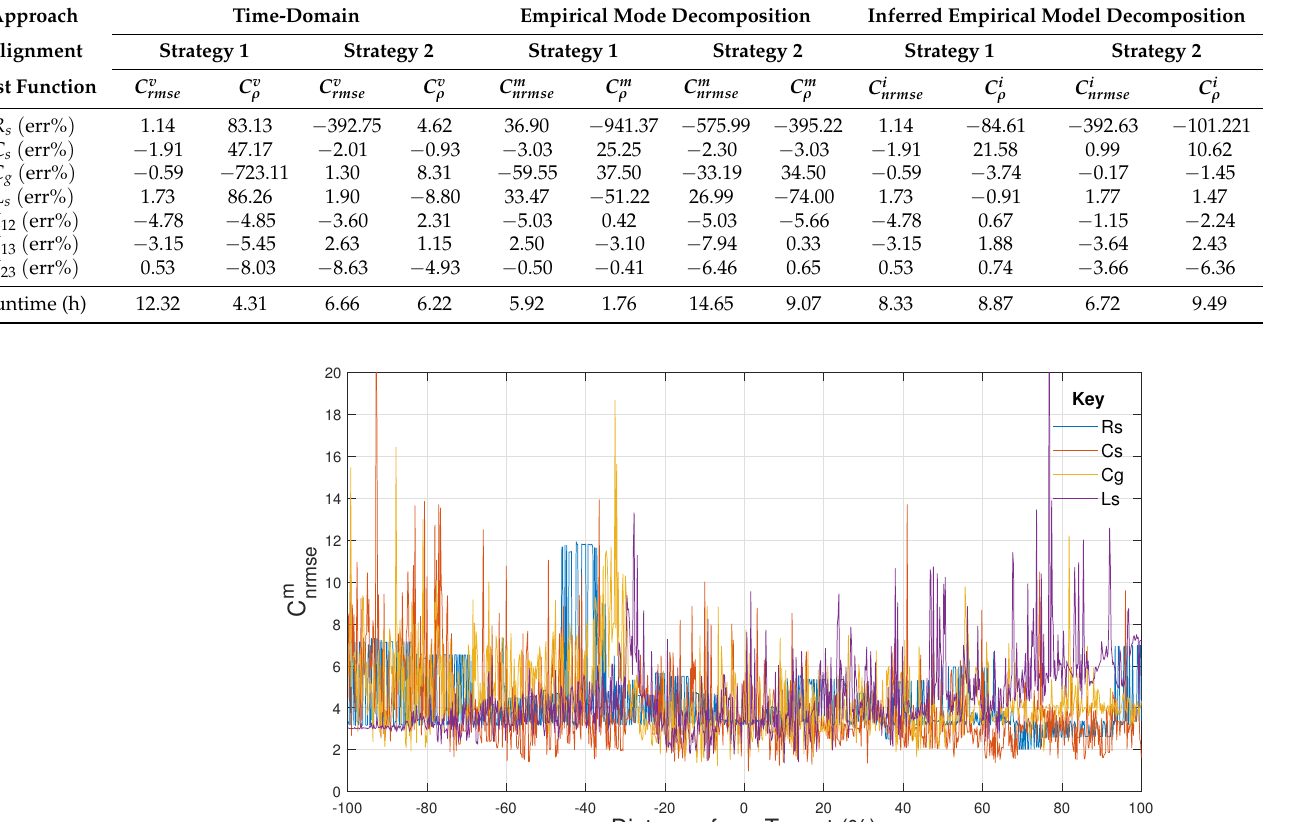
Table 4. Estimated Model Parameter Error Percentages obtained through the Time Domain Approaches.